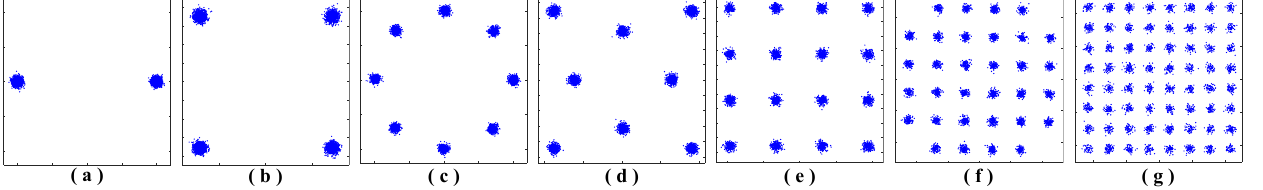
Figure 4. Signals after the principal axes correcting based on PCA. ( a − g ) BPSK, QPSK, 8PSK and 8/16/32/64 QAM, respectively.